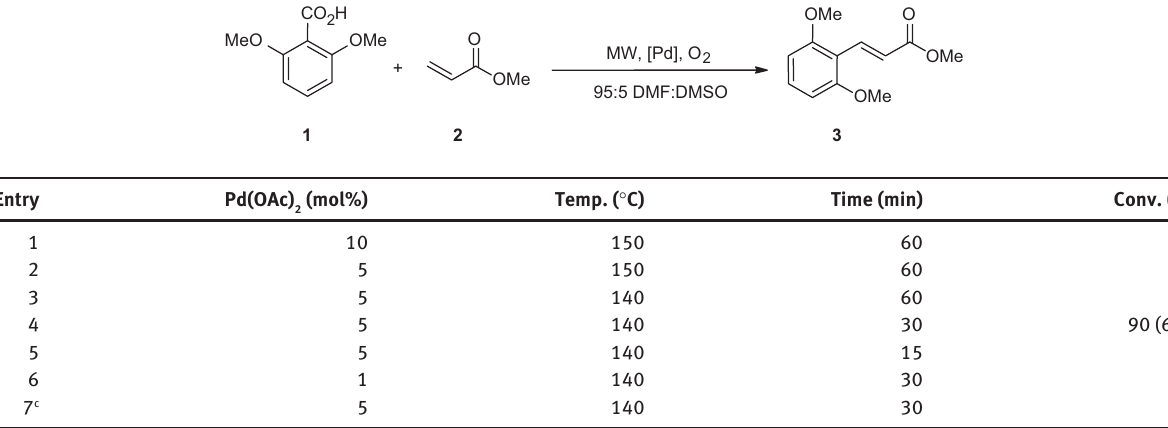
DMF:DMSO as the solvent; we loaded our reaction vessel